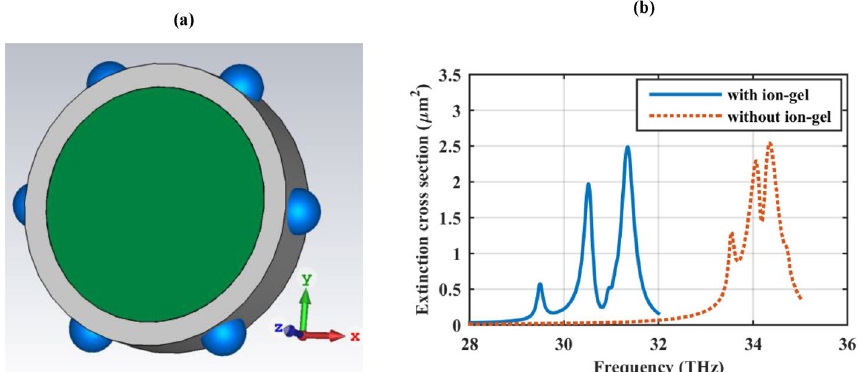
Figure 5. ( a ) The 3D geometry of the dielectric cylinder with hexamer cover biased by an ion-gel layer (gray color) and ( b ) its extinction cross-section. The design parameters are as follows: r c = 500 nm, ε c = 2, r s = 100 nm, h = 250 nm, τ = 1.5 ps, and μ c = 0.5 eV. The spherical particles are considered hollow. The thickness and refractive index of the ion-gel layer are respectively 100 nm and